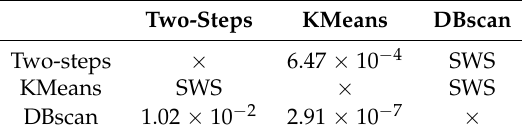
Table 8. p -values for instance 4.10.